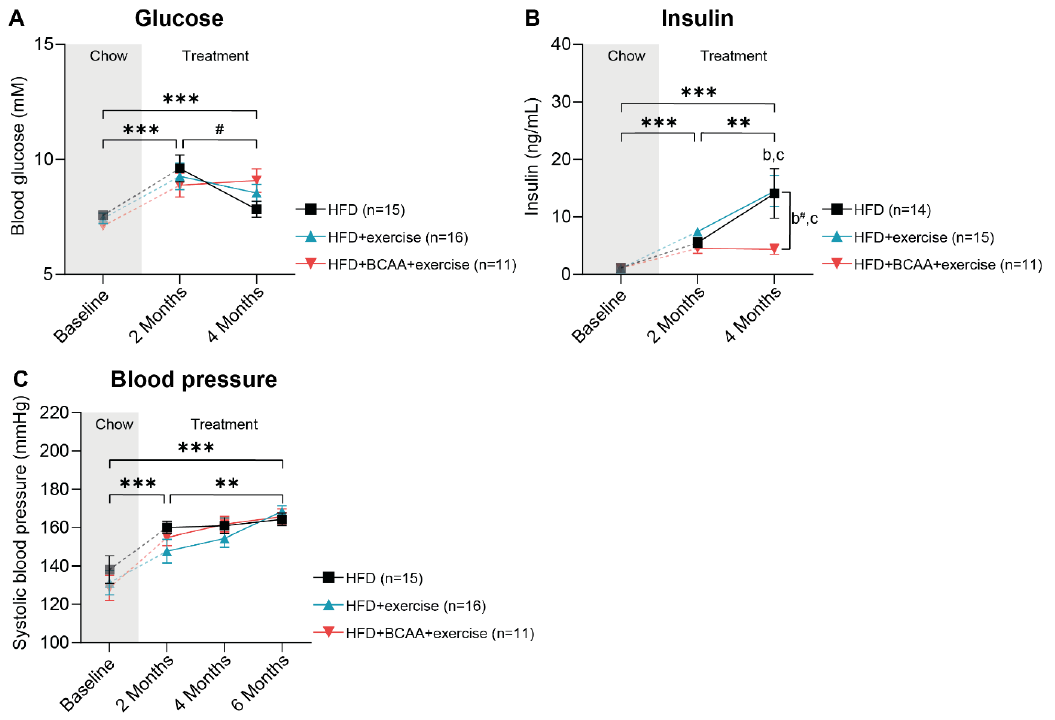
Figure 3. Metabolic markers and systolic blood pressure. ( A ) Fasting blood glucose levels and ( B ) plasma insulin levels measured in the HFD, HFD + exercise and HFD + BCAA + exercise groups at baseline (chow) and after 3 and 6 months of treatment. ( C ) Systolic blood pressure was assessed in mice of all experimental groups at baseline and at three separate time points after group allocation (2, 4, 6 months). High-fat diet (HFD), branched-chain amino acids (BCAA). Data are presented as mean ± SEM. ** p < 0.01, *** p < 0.001, # 0.05 < p < 0.08 (trend); b: significant difference HFD vs. HFD + BCAA + exercise group, c: significant difference HFD + exercise vs. HFD + BCAA + exercise group.